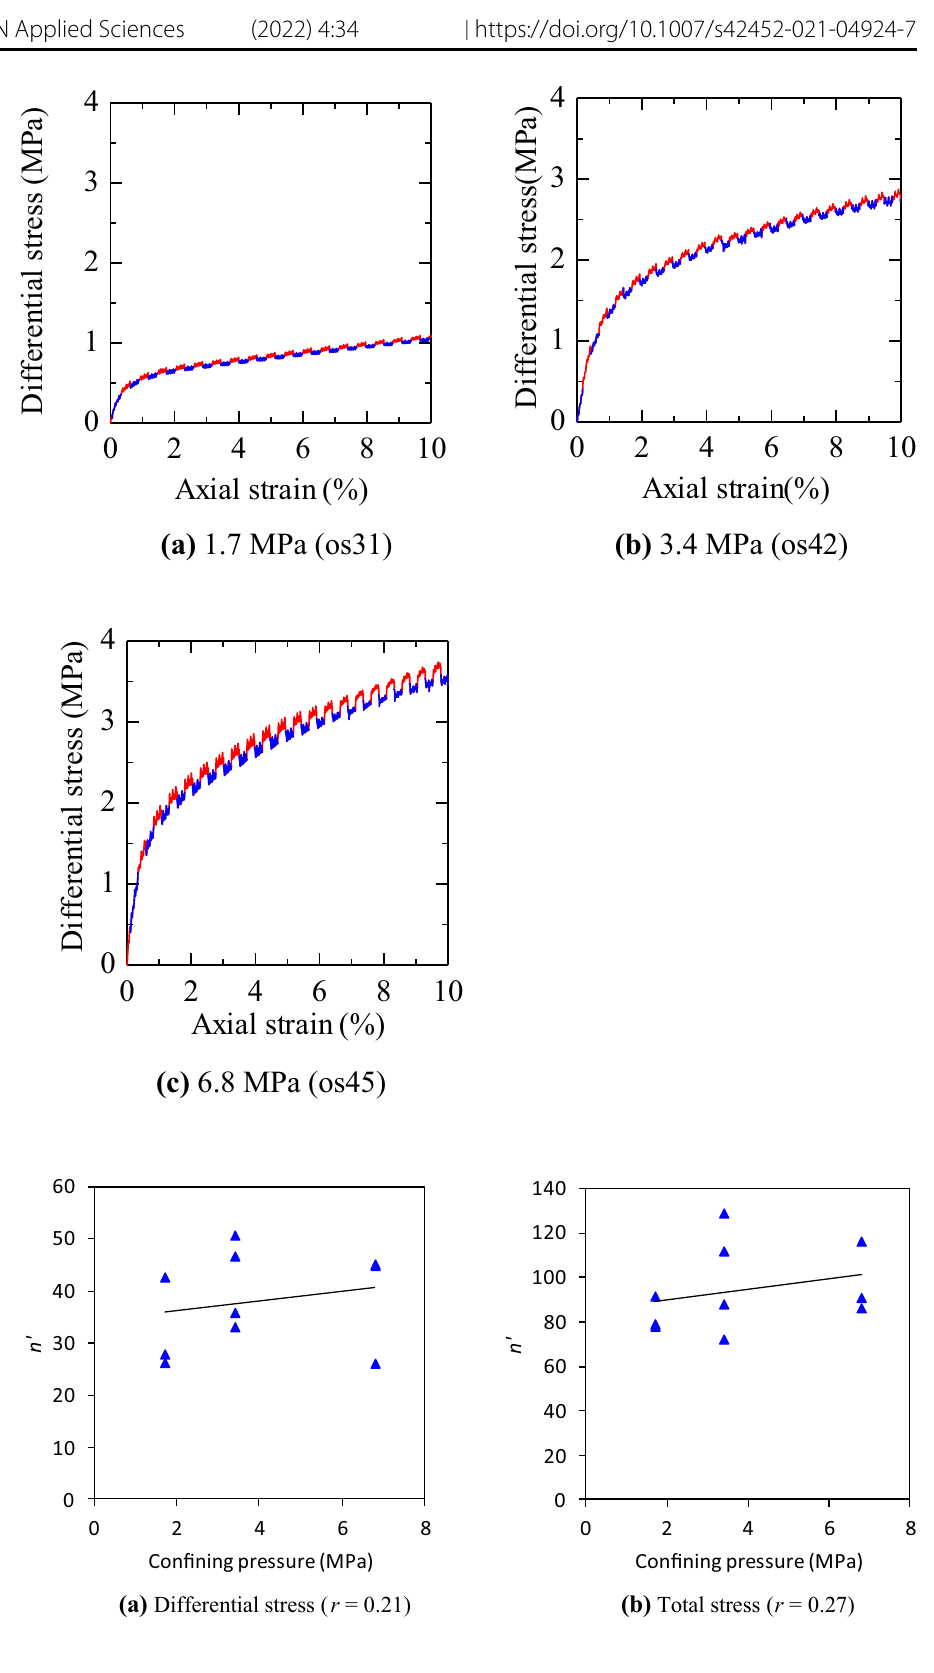
Fig. 14 Examples of triaxial stress–strain curves. Red and blue lines denote the axial strain at 10 − 4 s − 1 and 66 10 − 5 s − 1 , respectively